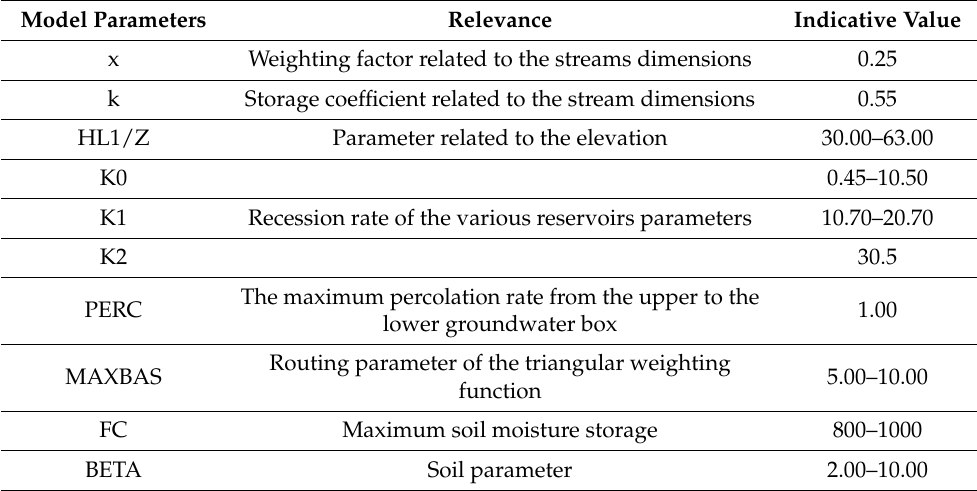
Table 1. Main calibration parameters of the HBV